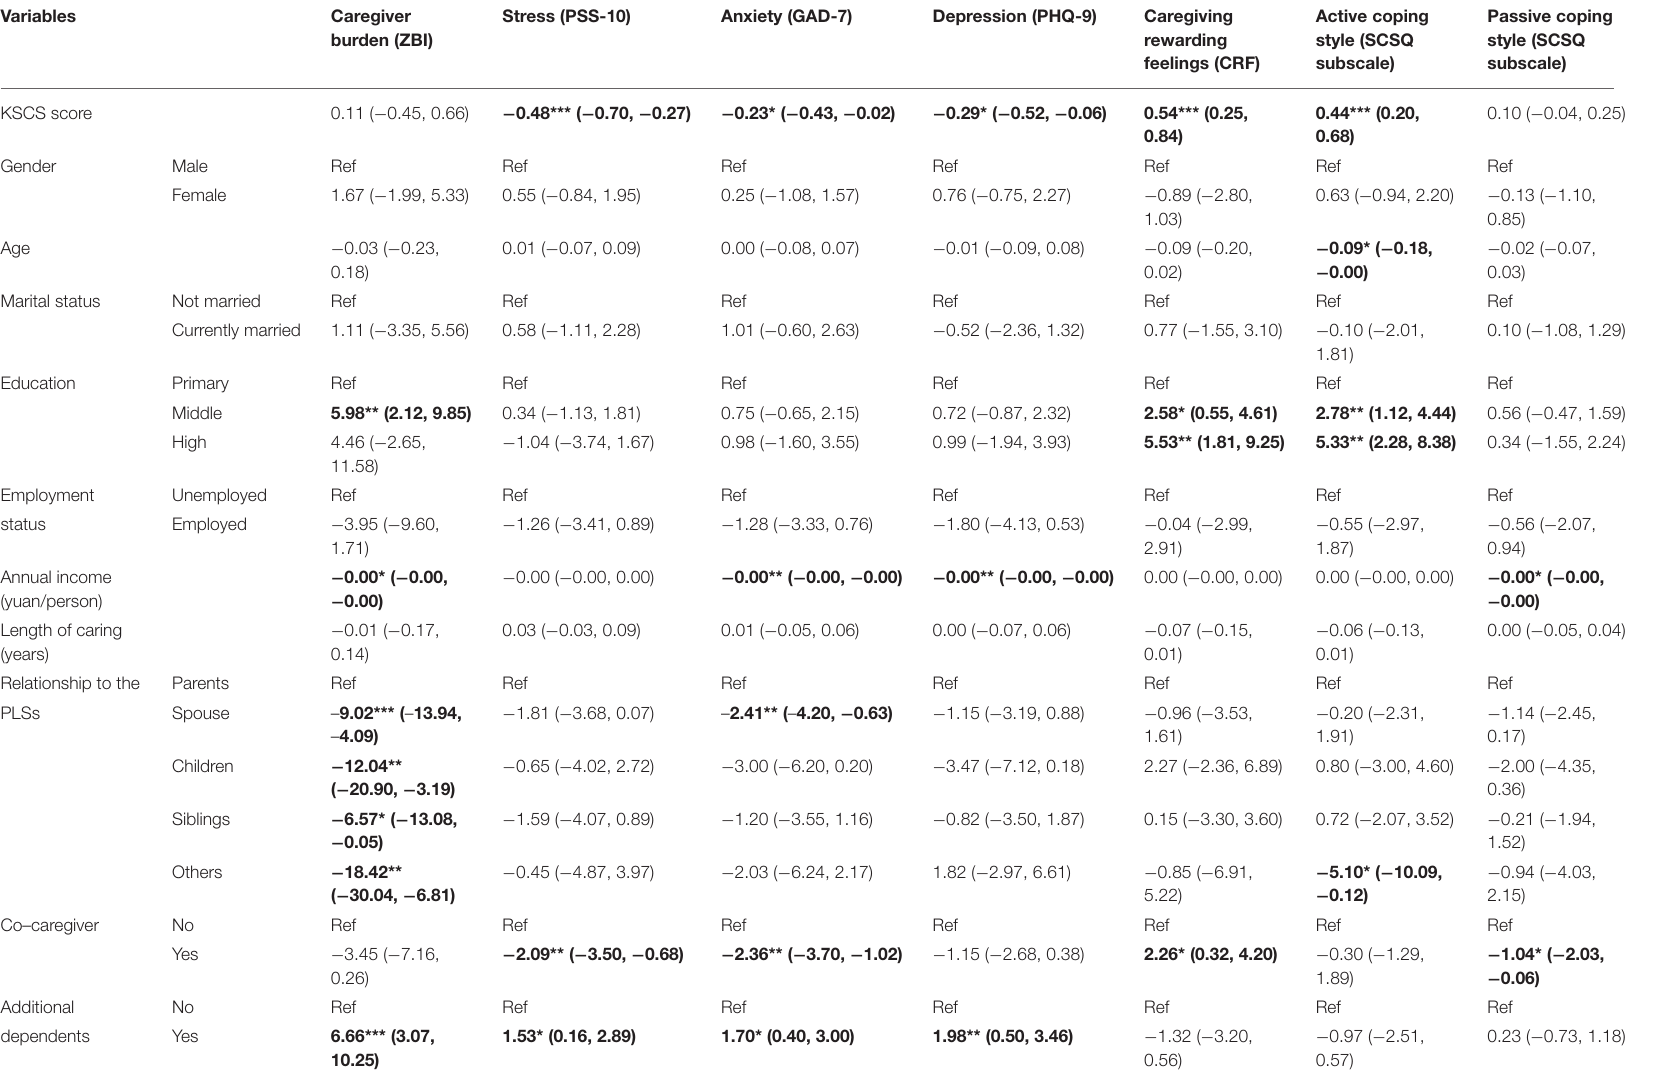
TABLE 3 | Multivariate linear regression analysis of KSCS scores predicting caregiving